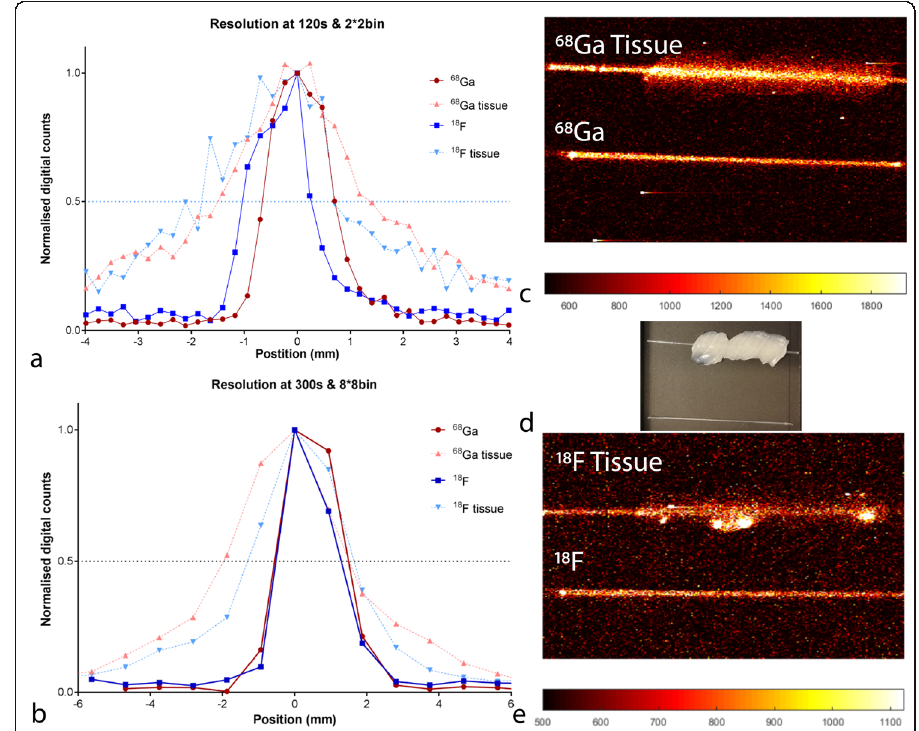
Fig. 2 The FWHM of 18 F (blue) and 68 Ga (red) for 120 s and 2 × 2 binning ( a ), 300 s and 8 × 8 binning ( b ), the influence of tissue on spatial resolution is displayed in light blue and light red. Signal intensities were normalized, to correct for the difference in activity and intensity of 18 F and 68 Ga. ( d ) Shows a white-light image of the glass capillary tubes with and without tissue. In ( c ) the corresponding CLI image of 68 Ga and in ( e ) the CLI images where the capillaries are filled with 18 F. The CLI images visualized were used as input to determine the FWHM over a line profile. The displayed images were acquired with 120 s and 2 × 2